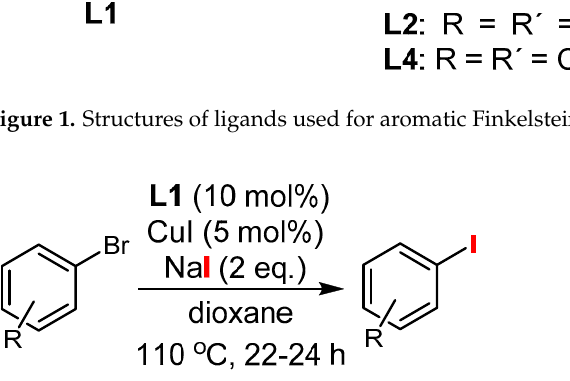
Figure 1. Structures of ligands used for aromatic Finkelstein reaction [55,61–63].